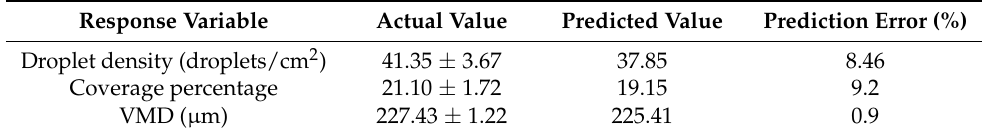
Table 7. Optimal condition, predicted and actual value, at optimized spray condition.